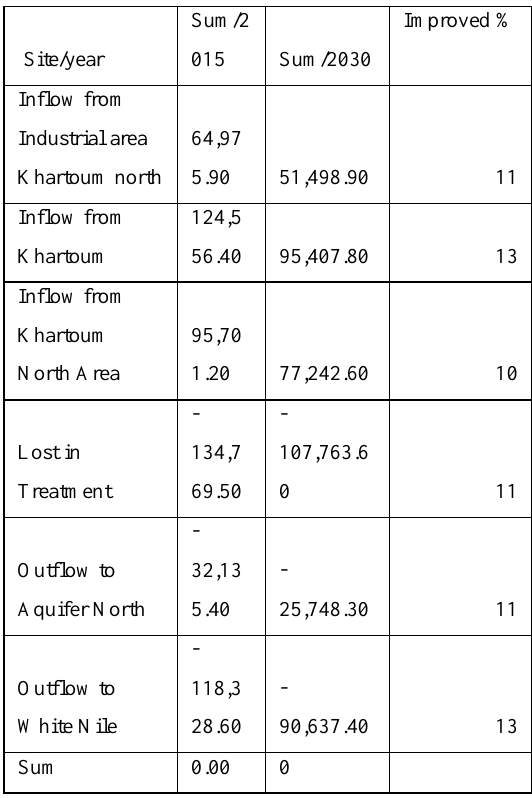
Table (1) Total Waste Water Inflow and Outflow